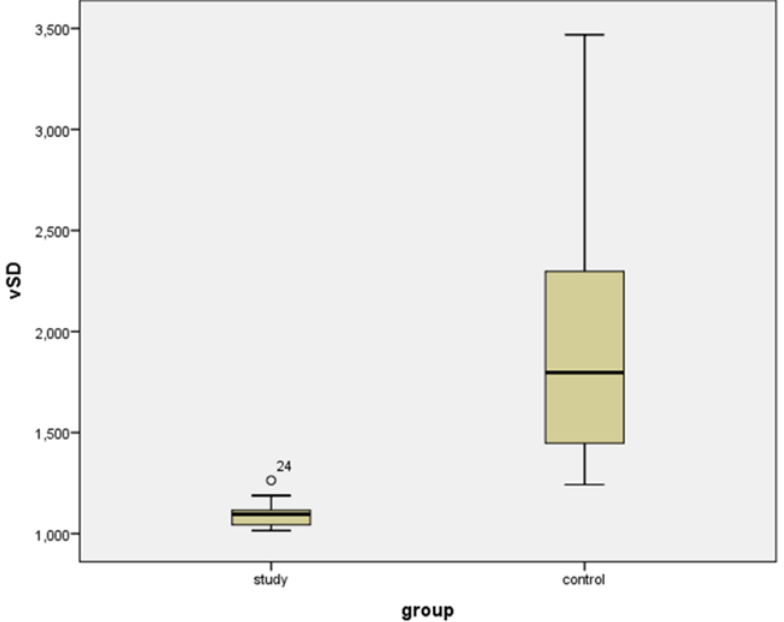
Figure 6. Box-plot for Vascularization Index (3D) in diastole (VIdias) for study and control group.